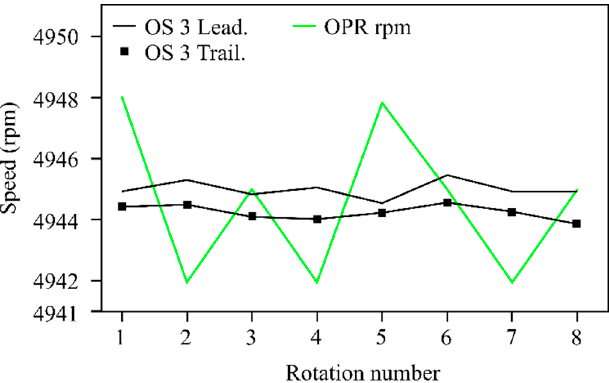
Figure 7. Comparison of the instantaneous speed of the turbine over several shaft turns given by OS 3 and the Once-Per-Revolution (OPR) signal. 3 and the Once-Per-Revolution (OPR)